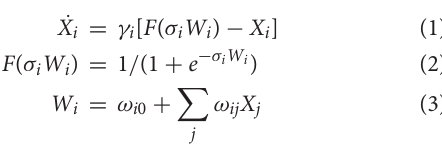
mTORC1 are important nutrient-sensing protein kinases that have antagonistic functions in regulating metabolic